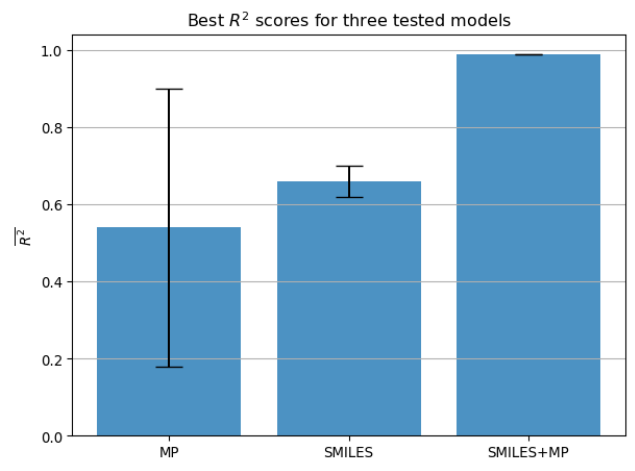
Figure 7. The best results achieved with each of the neural network configurations, evaluated using R 2 metric (higher is better), expressed as mean across folds and standard error (MP—molecular properties, R 2 —coefficient of determination).